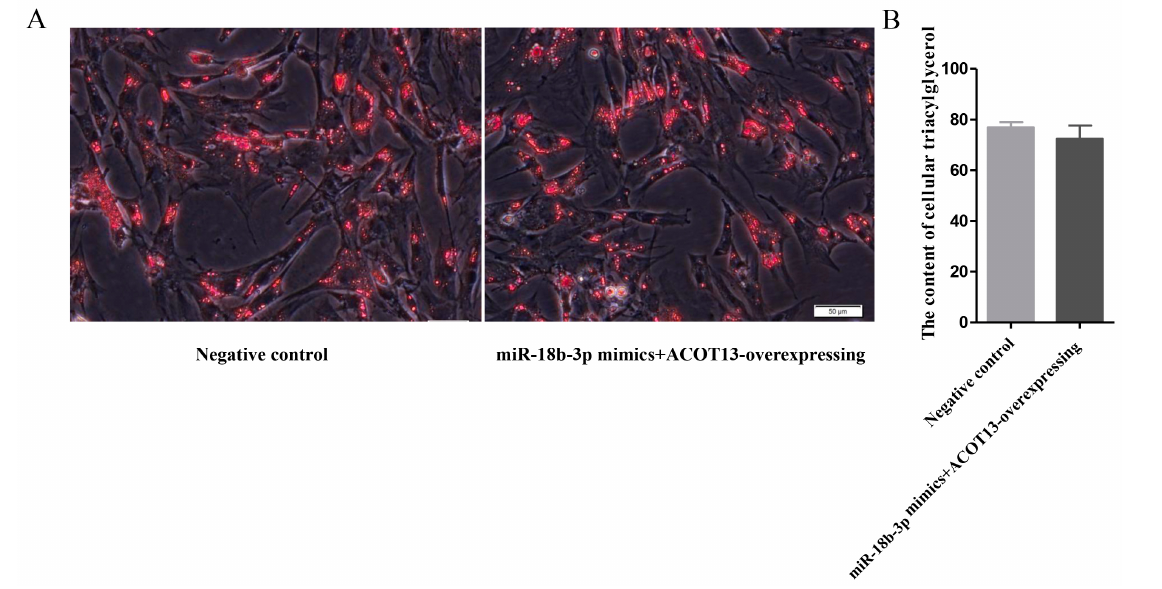
Figure 8. Rescue experiment of ACOT13 , co-transfecting with miR-18b-3p mimics and ACOT13 overexpression. ( A ) Lipid droplet formation between groups. ( B ) Triacylglycerol content between groups.